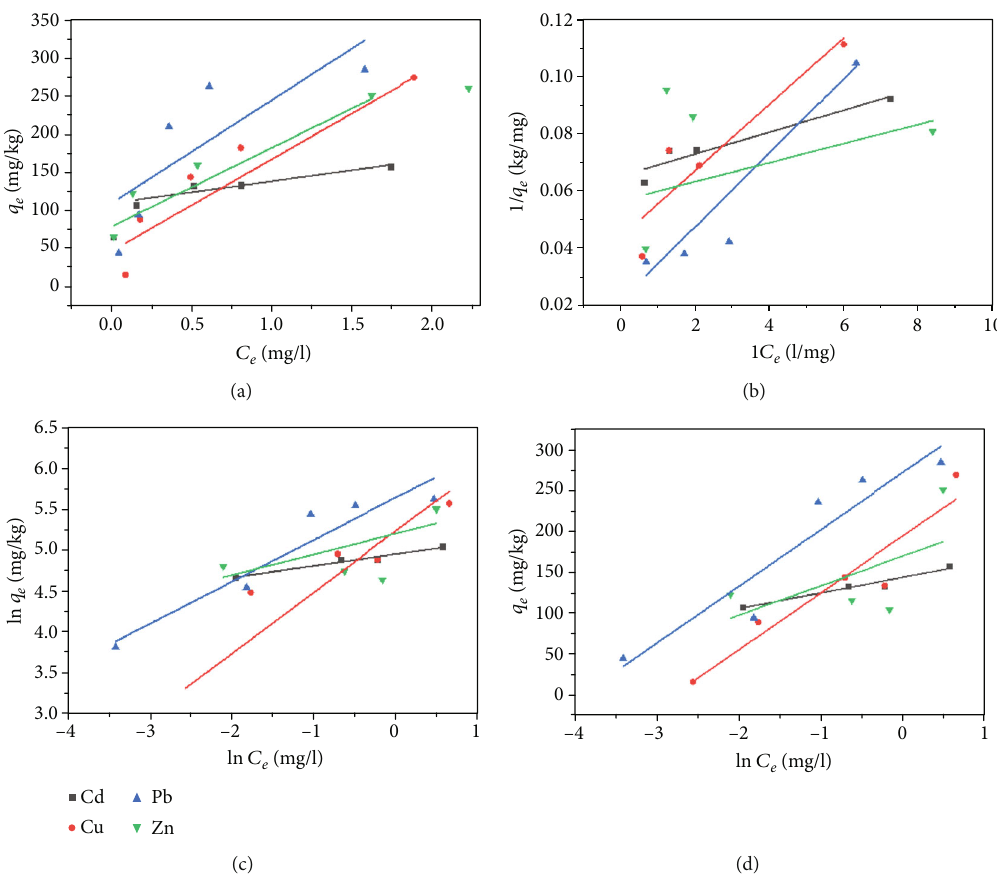
Figure 4: (a) Henry model, (b) Langmuir model, (c) Freundlich model, and (d) Temkin model ( V = 20 mL, temperature at 298K, t = 48 h). Table 3: Regression parameters of Henry and Langmuir models for Table 4: Regression parameters of Freundlich and Temkin models adsorption isotherms of heavy metals on microplastics. for adsorption isotherms of heavy metals on Henry model Absorbate